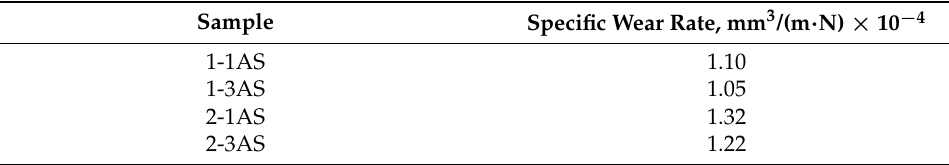
Figure 8. Coefficient of friction versus time for different samples ( a ) and SEM-BSE images of wear surfaces ( b ). Table 4. Wear rate of the fabricated samples in sliding friction.